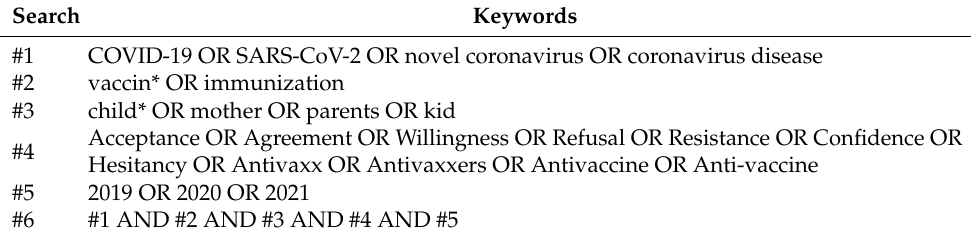
Table 1. Search strategy